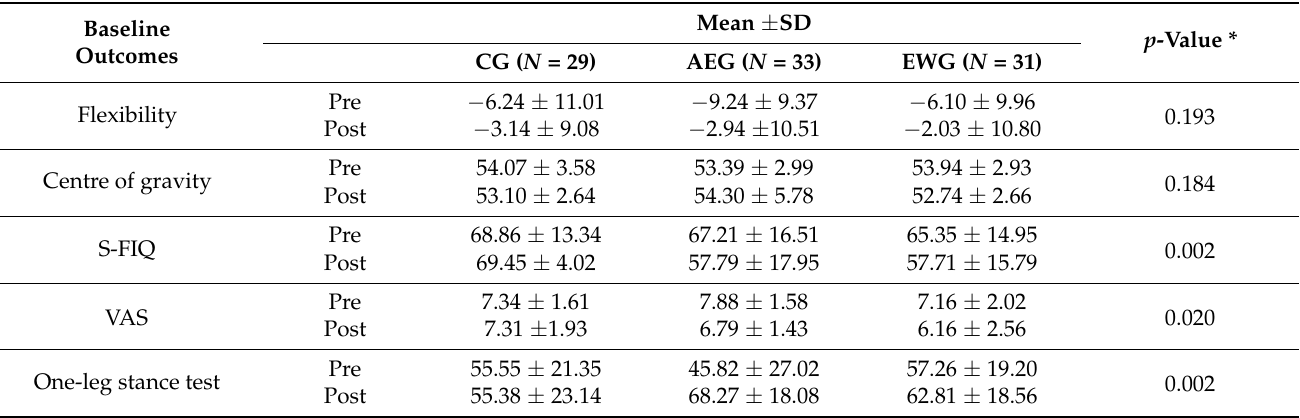
Table 2. Baseline and results of the post-intervention outcome measures.